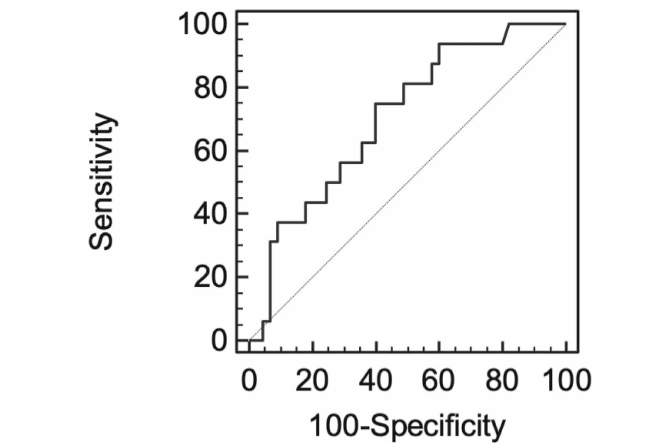
Figure 2 - Receiver operating curve used to define optimal cut off value of NLR for non-localized